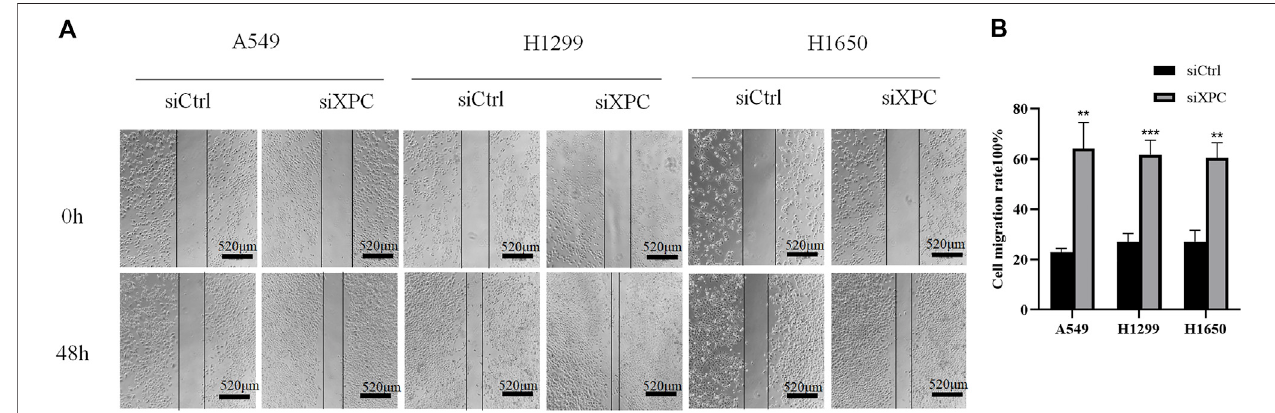
FIGURE 6 | DecreasedXPCexpressionpromotescellmigration. (A) .Cellscratchtesttodetectcellmigrationrate.Allbarinthe fi gure (cid:1) 520 μ m. (B) .UseImageJtocount thehealingareaofcellscratches.Cellmigrationrate (cid:1) [(S areaat0h – S areaat48 h )/S areaat0 h ] × 100%.ThecellmigrationrateofthesiXPCgroupwassigni fi cantlyhigherthanthatofthe siCtrl group ( **p < 0.01, ***p < 0.001).